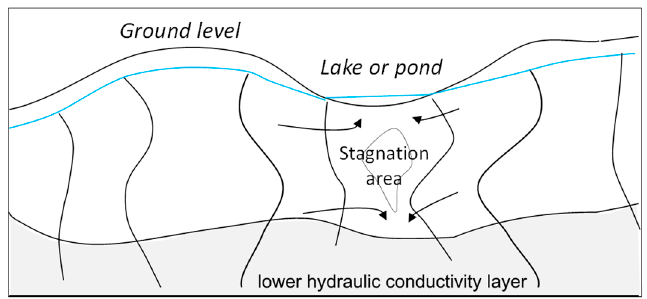
Figure 6. Example of a stagnation area (arrows represent flow lines, the light-blue line represents the phreatic surface, and the black lines represent the vertical head contours).